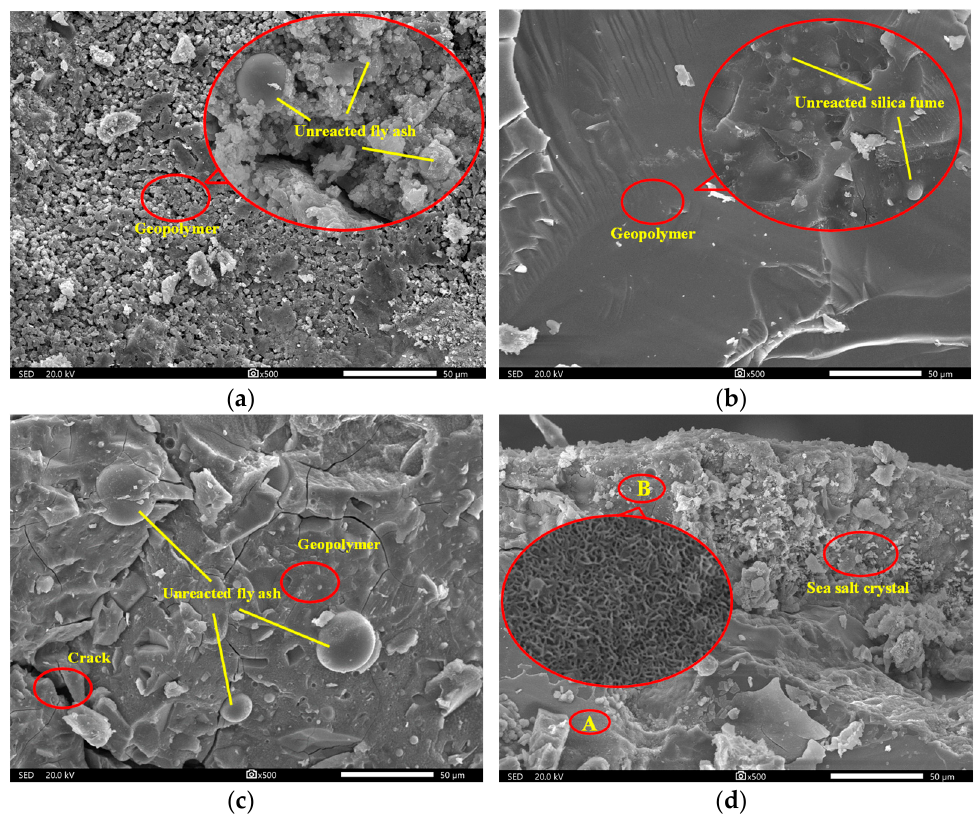
Figure 2. SEM images of GPM: ( a ) Ae = 3%, Mo = 1.2; ( b ) Ae = 9%, Mo = 1.2; ( c ) Ae = 9%, Mo = 1.8; ( d ) Ae = 9%, Mo = 1.8, eroded by 270 days.